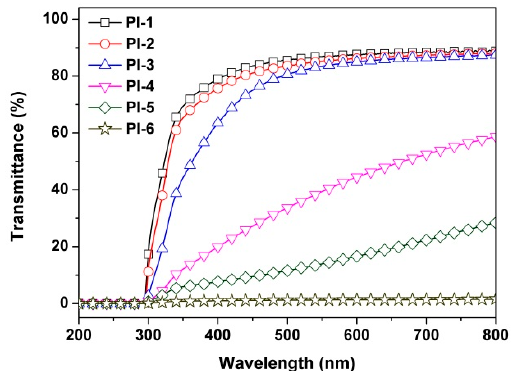
Figure 6. UV-Vis spectra of PI films. (film thickness: ~50 µ m).